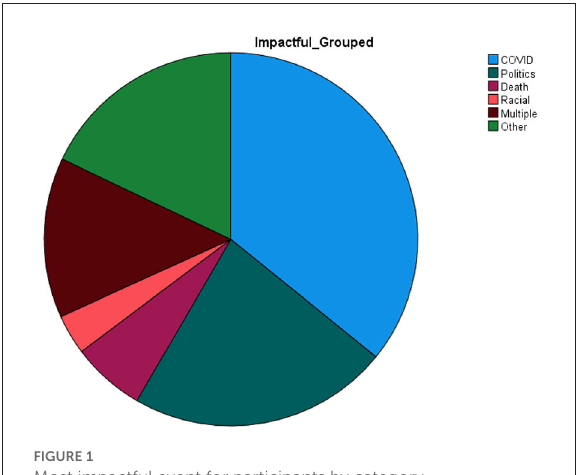
FIGURE1 Most impactful event for participants by